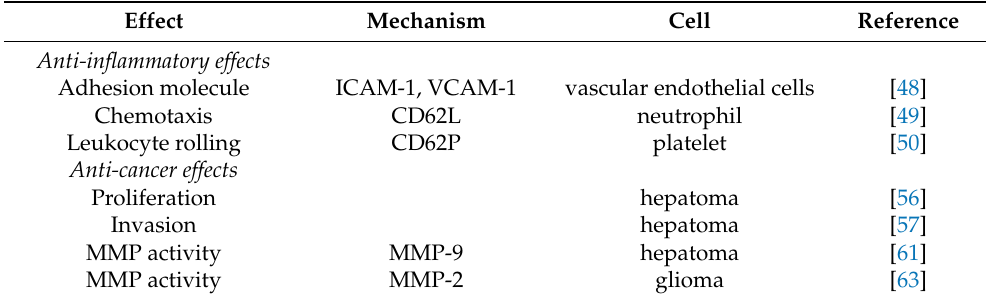
Table 1. The biological effects of CFGAs and the underlying molecular